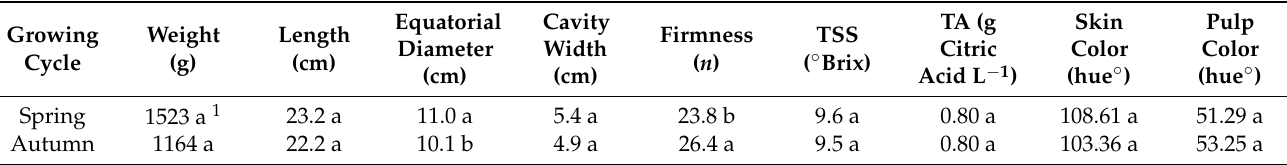
Table 3. Fruit quality in ‘Intenzza’ papayas grown in spring versus autumn planting season. Fruit harvested with 50–60%